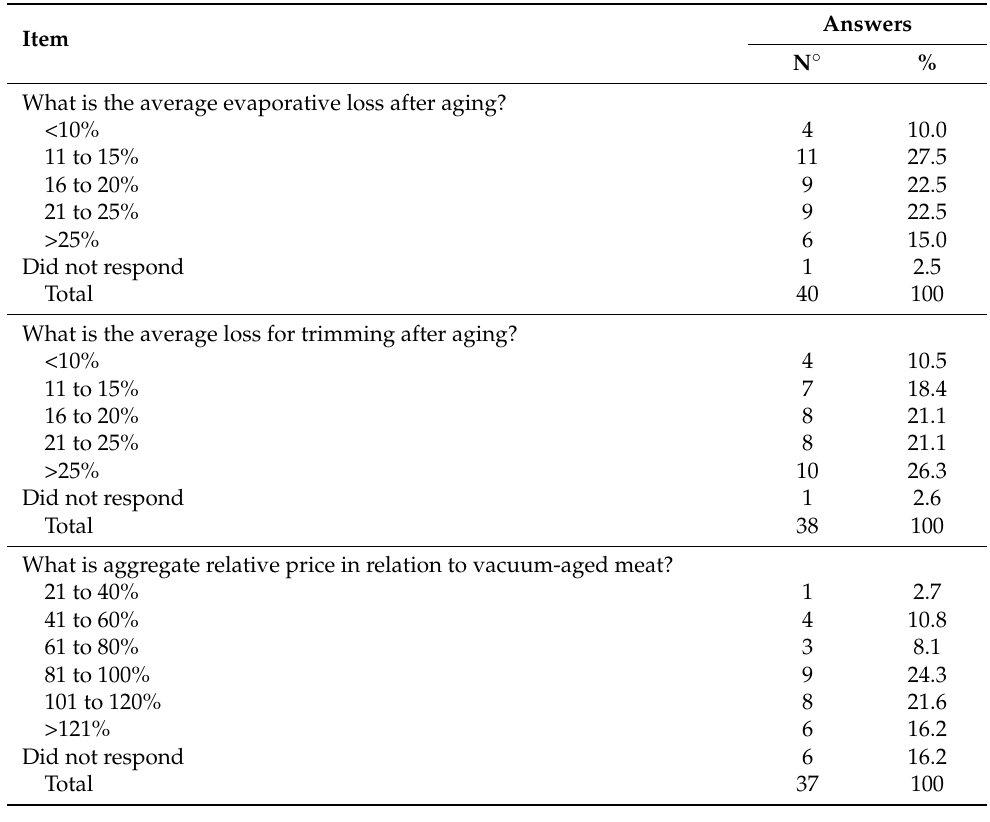
Table 7. Economic issues related to the production of dry-aged meats in